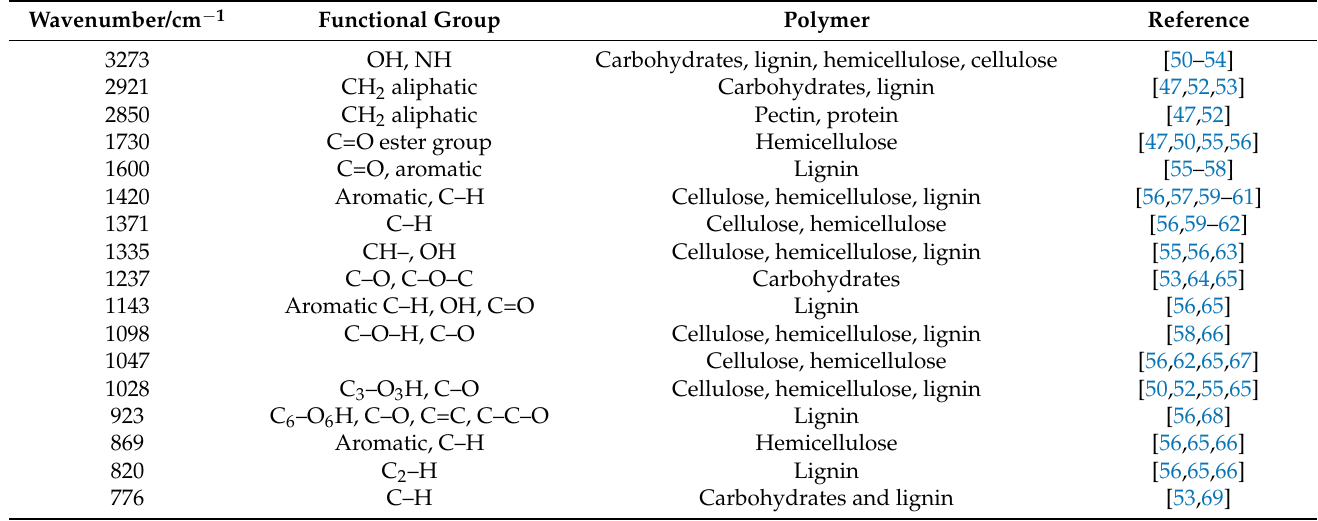
Table 2. Absorption frequencies of functional groups in the guava fruit